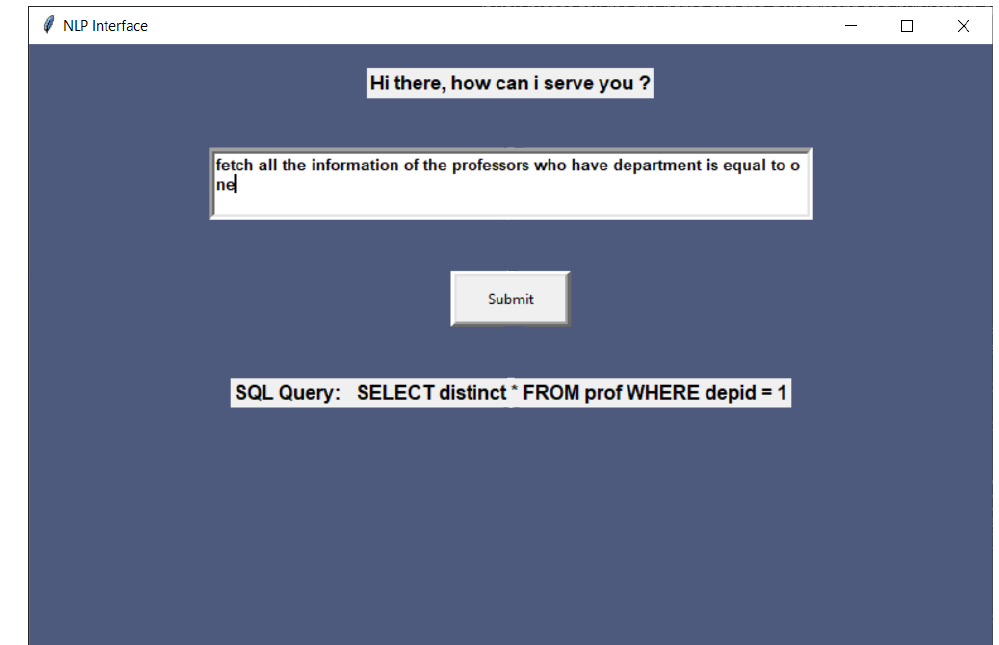
Figure 4. NLP interface query example (1) .